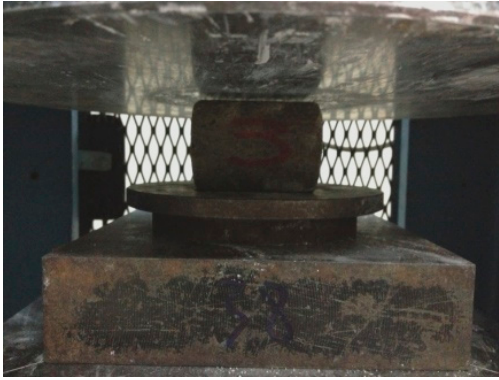
Figure 1. Setup for compressive strength tests.